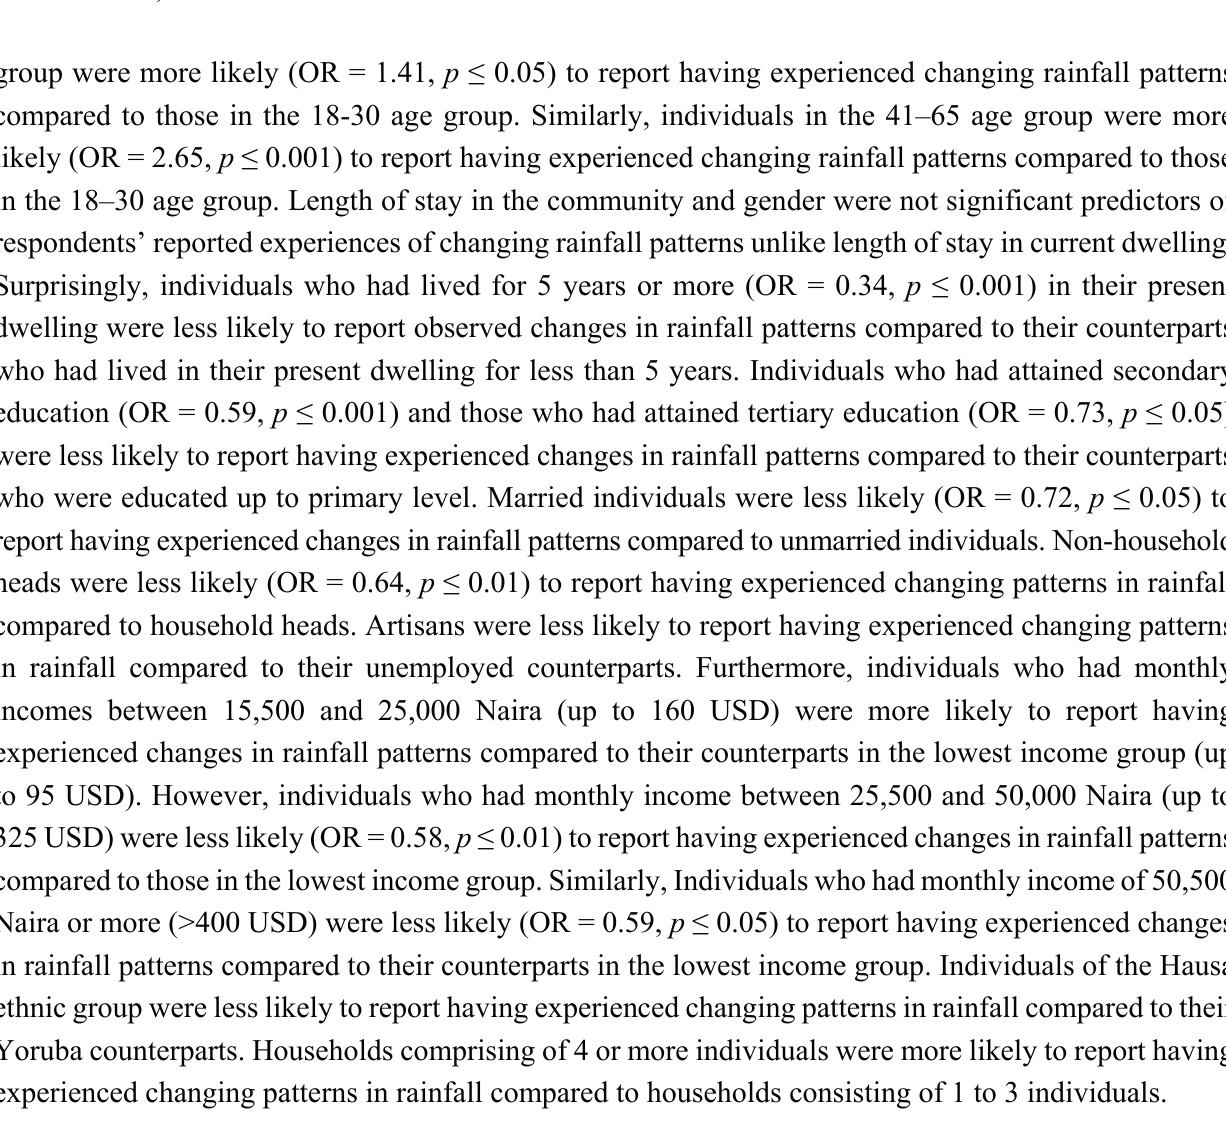
Table 2. Multivariate complementary log-log regression model predicting the experience of changing rainfall patterns by coastal communities in Lagos,